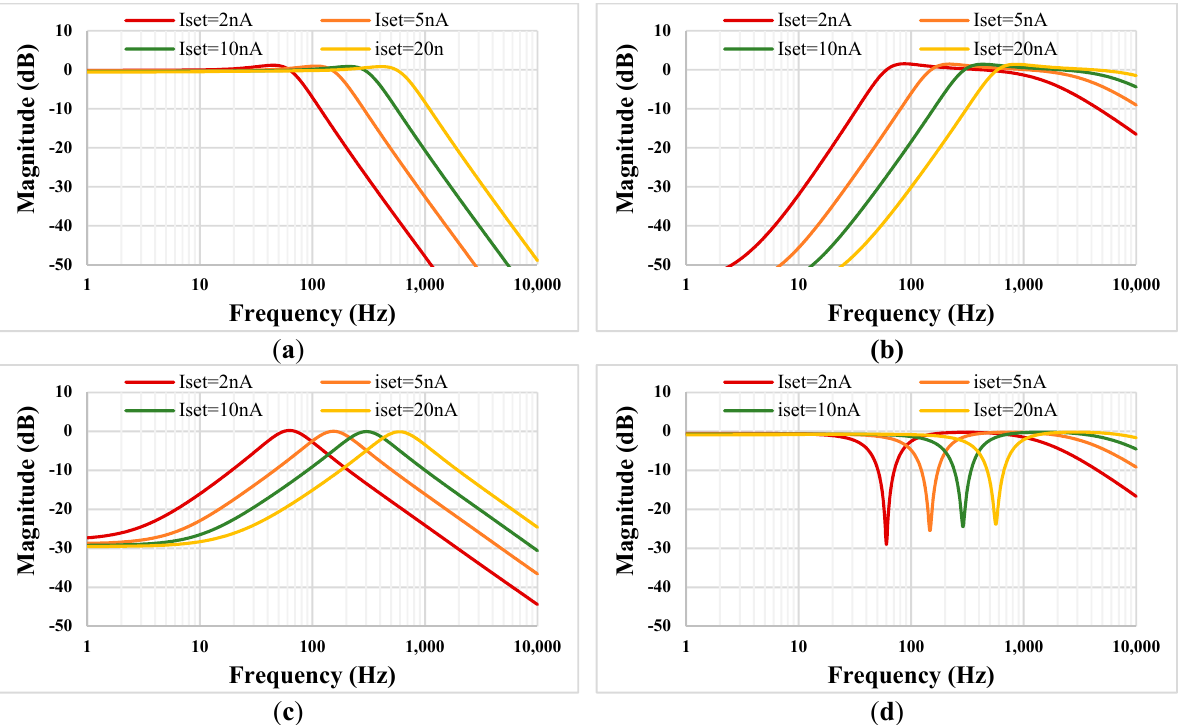
Figure 10. The simulated tuning capability of the proposed LPF ( a ), HPF ( b ), BPF ( c ) and BSF ( d ).